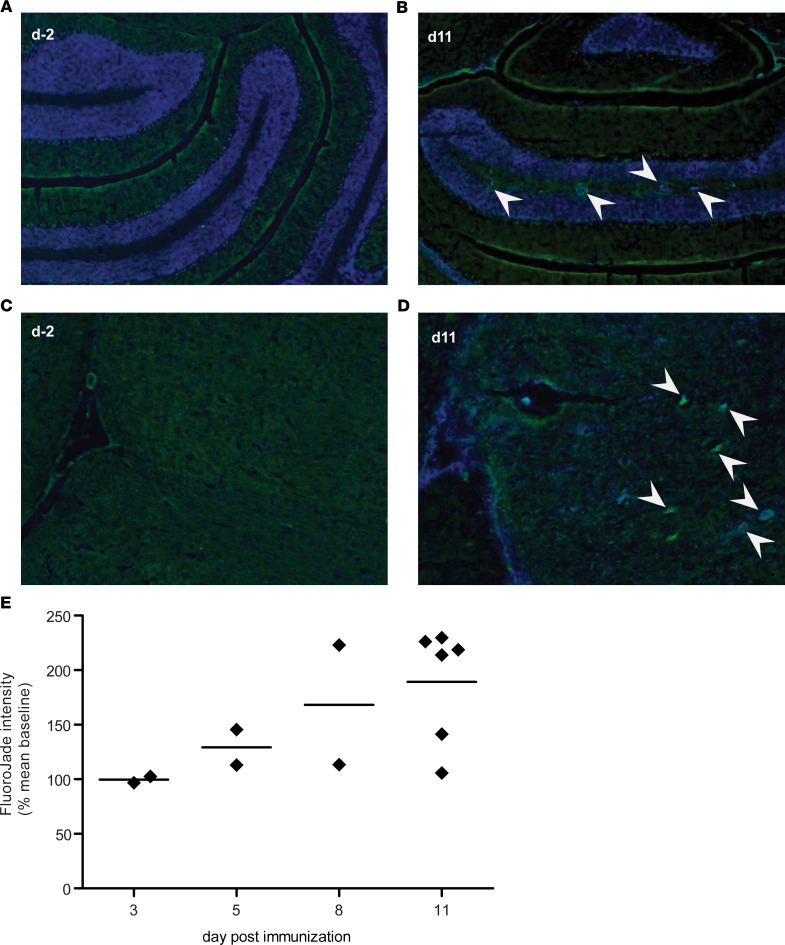
Modest neurodegeneration detected by Fluoro-Jade staining during early EAE.(A and C) No evidence of Fluoro-Jade+ staining was seen in brain tissue sections from unimmunized control mice; representative images of cerebellum (A) and brainstem (C). (B and D) Fluoro-Jade+ foci (indicated with arrows) were observed in cerebellum (B) and brainstem (D) of mice at day 11 p.i. (Fluoro-Jade, green; DAPI, blue). The Fluoro-Jade+ foci consistently accompanied inflammatory foci (B and D). (E) Quantification of fluorescence intensity of the tissue section showed an increasing accumulation of Fluoro-Jade staining by day 11 p.i. (arbitrary units) (n = 15).